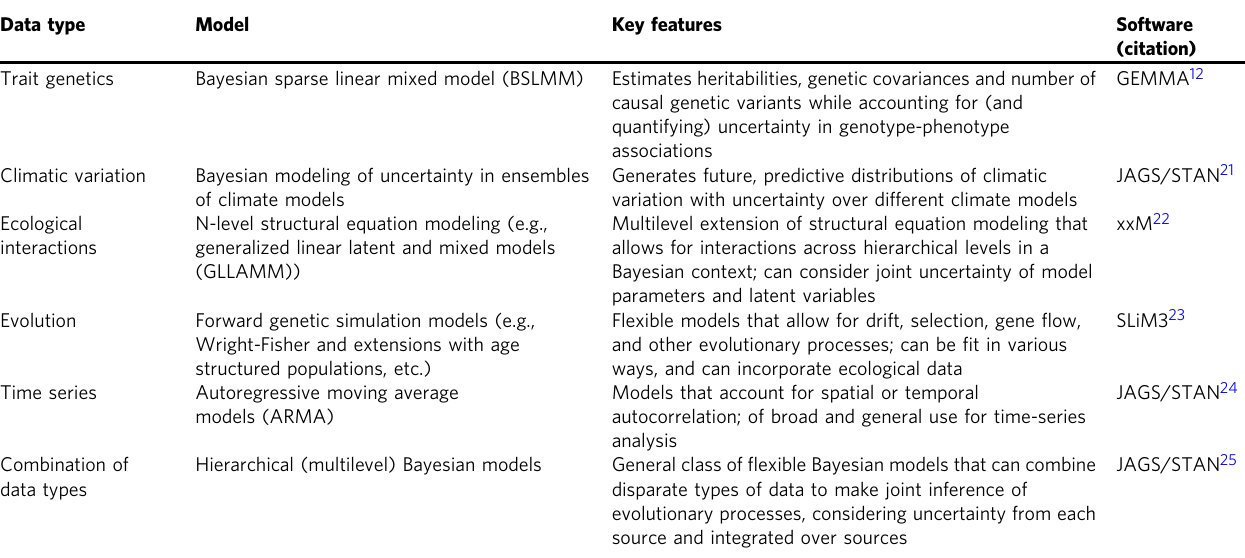
Table 1 Examples of data types and models that can aid the quanti fi cation of uncertainty related to predicting evolution over moderate time